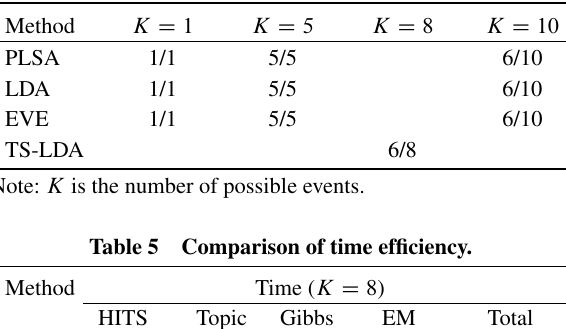
Table 4 Comparison of precision.